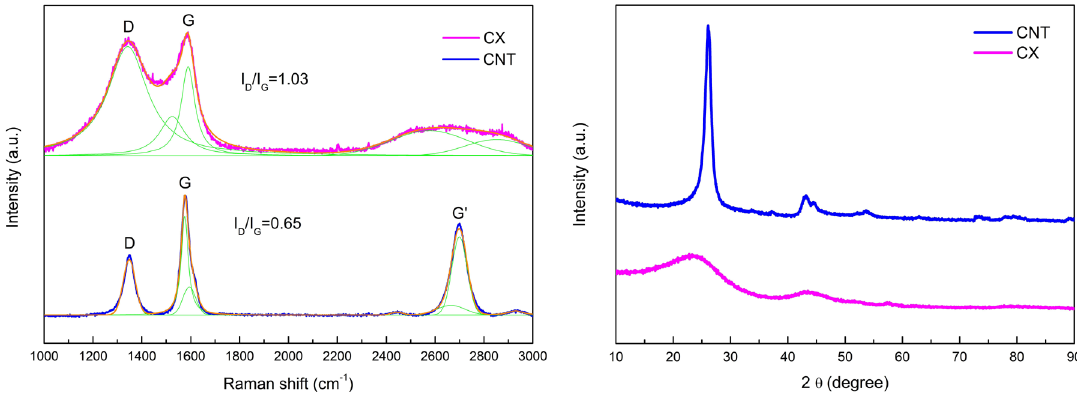
Figure 4. CX and CNT Raman spectra. Figure 5. X-Ray Diffractogram of CX and